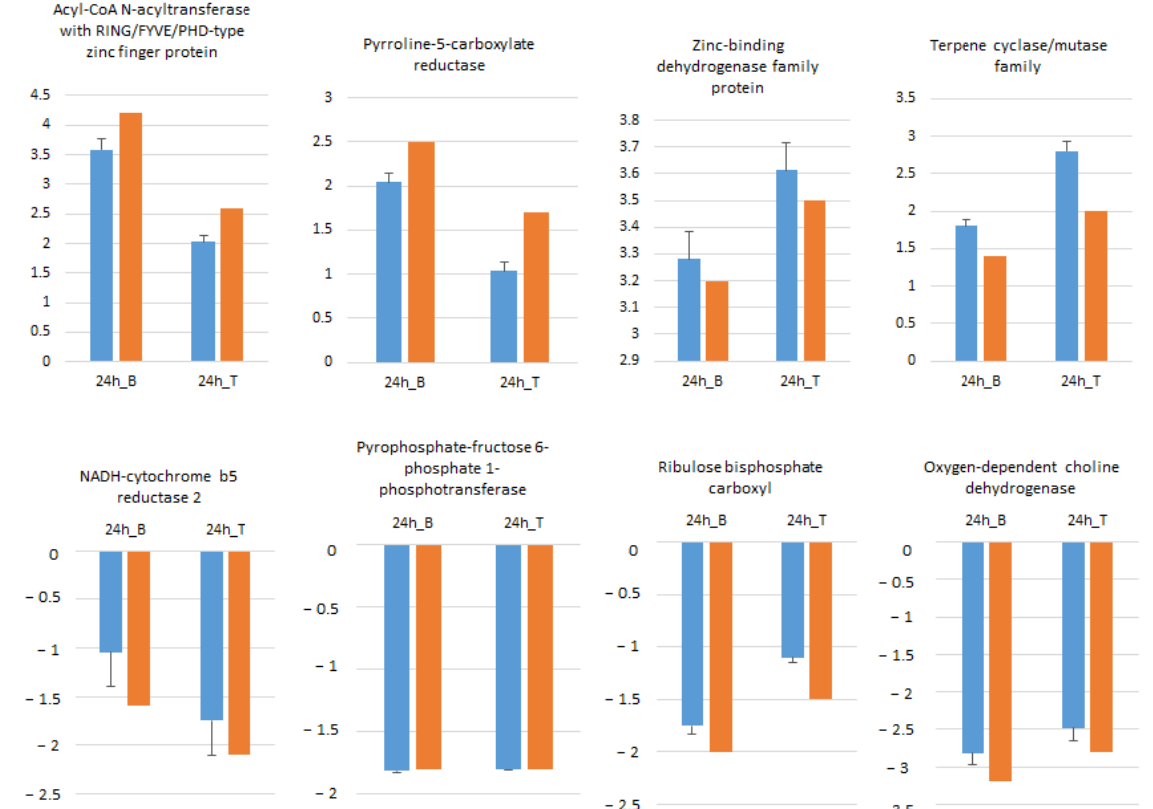
Figure 7. Expression pattern validation of eight randomly selected genes in Boulifa and Testour leaves by qRT-PCR. The blue bar indicates the relative expression level determined by qRT-PCR using the 2 − ∆∆ CT method mean with associated standard error bar ( n = 3) and alpha tubulin (TUB2) was used as reference gene for data normalization. The orange bar represents transcript abundance changes of RNA-seq data calculated by the Log2 fold change method.